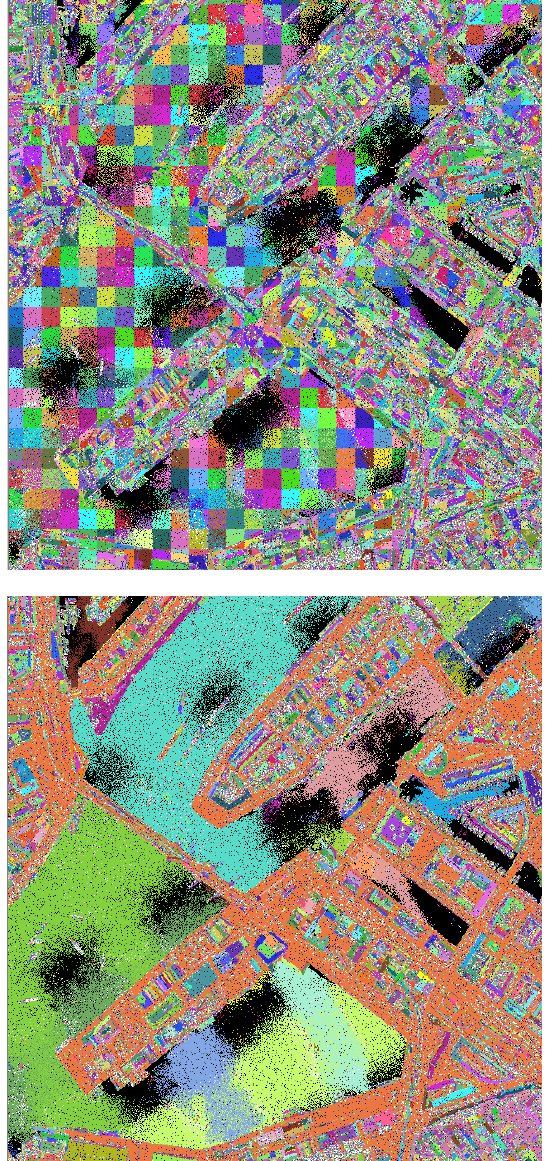
Figure 6. Segment merging in a larger data set. Top: segmentation results per tile. Bottom: merged segments.